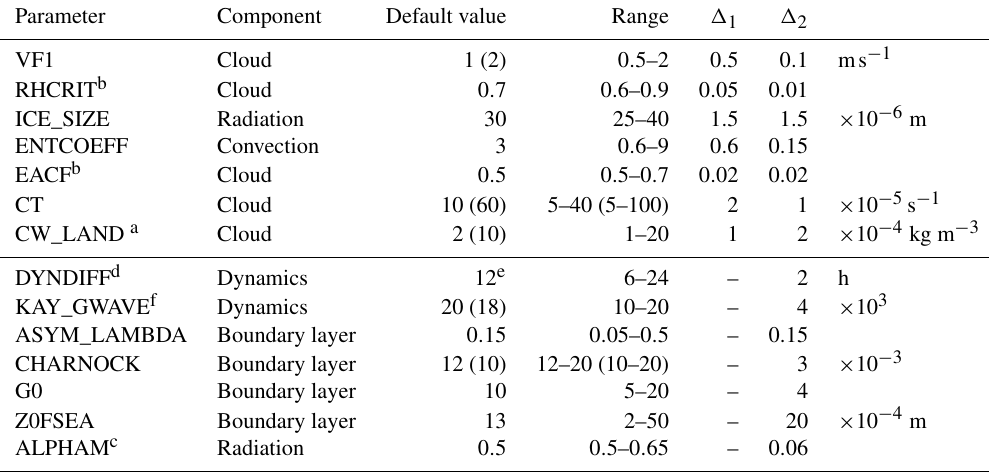
Table 1. Parameters, default values, and allowed ranges and perturbations. Shown for each parameter name are the component of HadAM3 they are from, the default value, allowed range, perturbations used in HadAM3–7 cases ( (cid:49) 1 ) and perturbations used in all HadAM3-14 cases and HadAM3P cases ( (cid:49) 2 ). For more information on the parameters see Yamazaki et al. (2013). Where HadAM3P values or ranges differ from HadAM3, these values are shown in